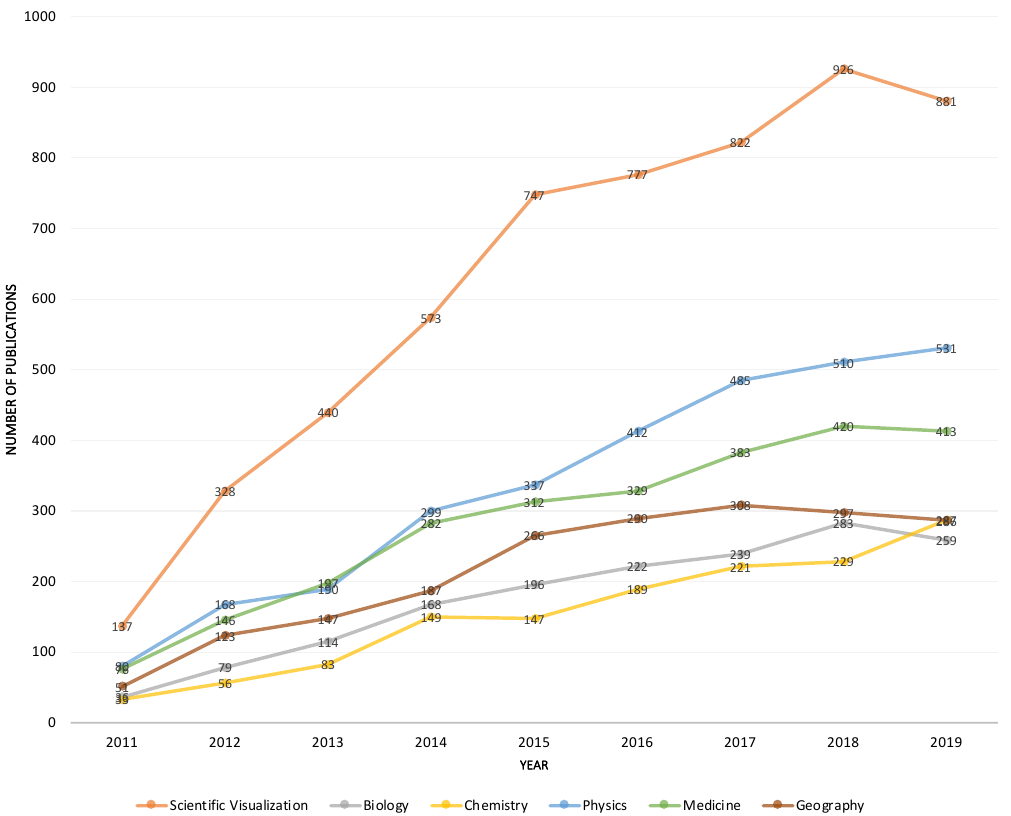
Figure 14. Trend analysis tracking of publications using WebGL since 2011. For individual scientific fields the number of publications containing the keyword WebGL is plotted for each